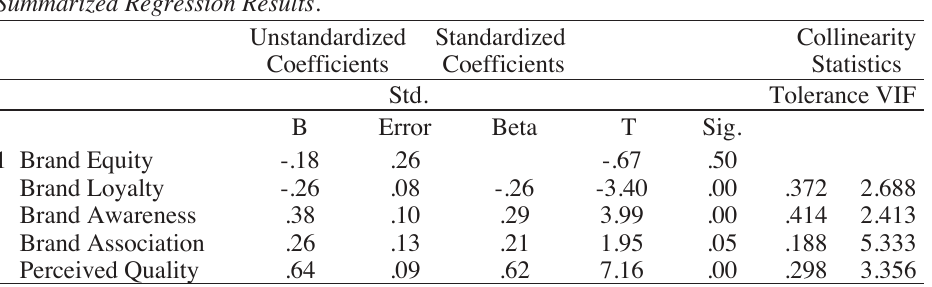
Summarized Regression Results.